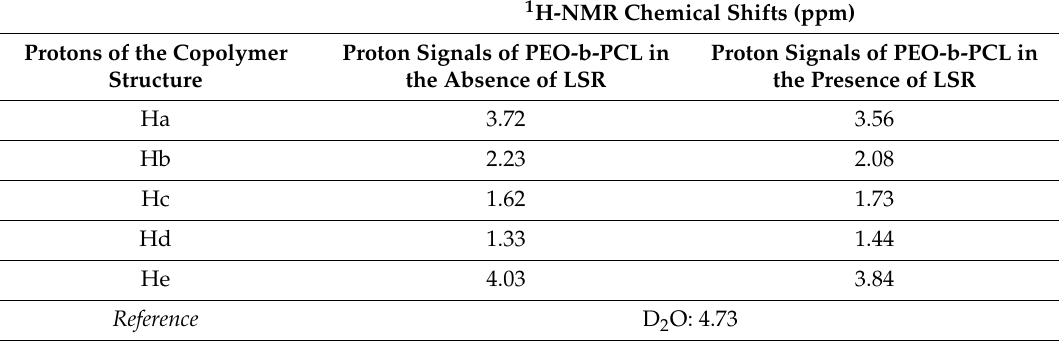
Table 3. H-NMR chemical shifts of PEO-b-PCL copolymer: (a) in the absence of LSR and (b) in the presence of LSR in D 2 O solutions.